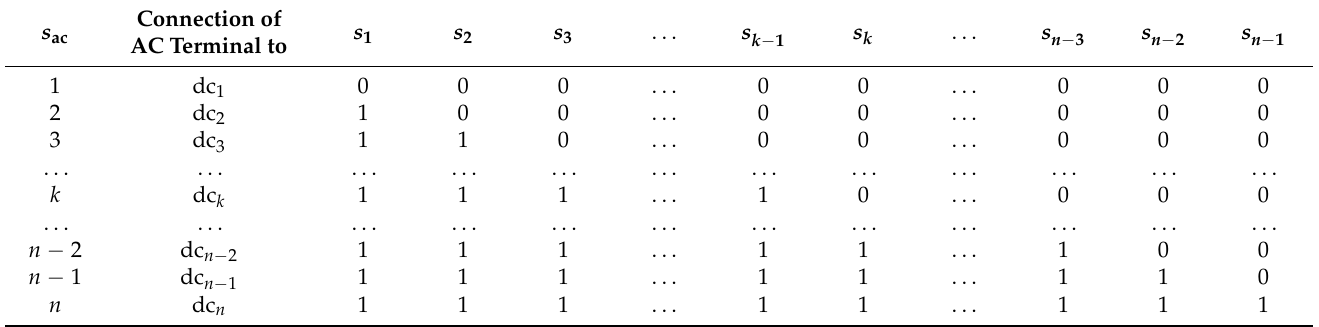
Figure 3 also indicates the binary control signal applied to every transistor ( s k ). A value equal to 1 indicates that the corresponding switch is ON , while a 0 value indicates that the switch is OFF . It can be seen that the devices from the same diagonal share the same control signal, and that devices from negative diagonals feature the complementary signal of devices from positive diagonals. Overall, the leg presents n − 1 independent control signals, from s 1 to s n − 1 . Table 1 defines the fundamental set of leg switching states to connect the leg AC terminal to each of the DC-link terminals [9]. It can be observed that the independent binary control signals follow a thermometric code. Table 1. NPC leg switching states [9].